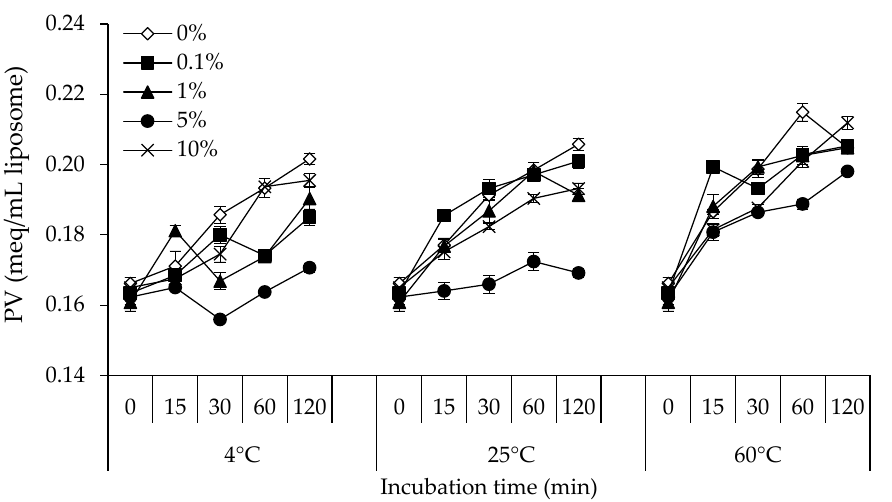
Figure 2. Changes in peroxide value (PV) of lecithin liposome model system added with 0, 0.1, 1, 5, and 10% ( v / v ) of stingray non-protein nitrogen (NPN) incubated at 4, 25 and 60 °C for 0, 15, 30, 60, and 120 min. Bars indicate the standard deviation from triplicate determinations.